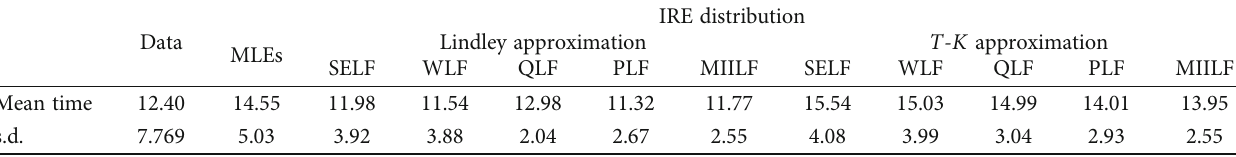
Table 5: Mean and standard deviation of data and IRE distribution using MLEs and Bayes